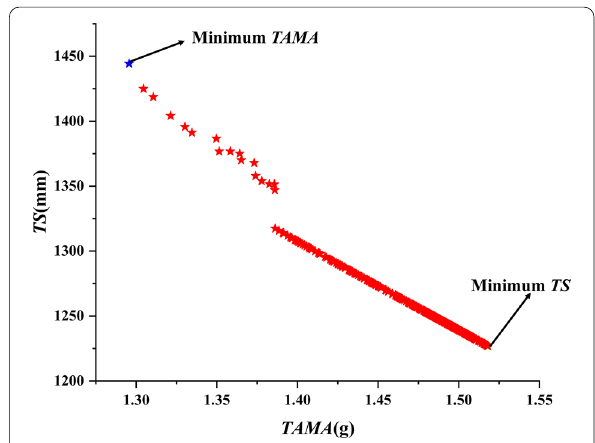
Figure 9 Pareto frontier optimal solution set